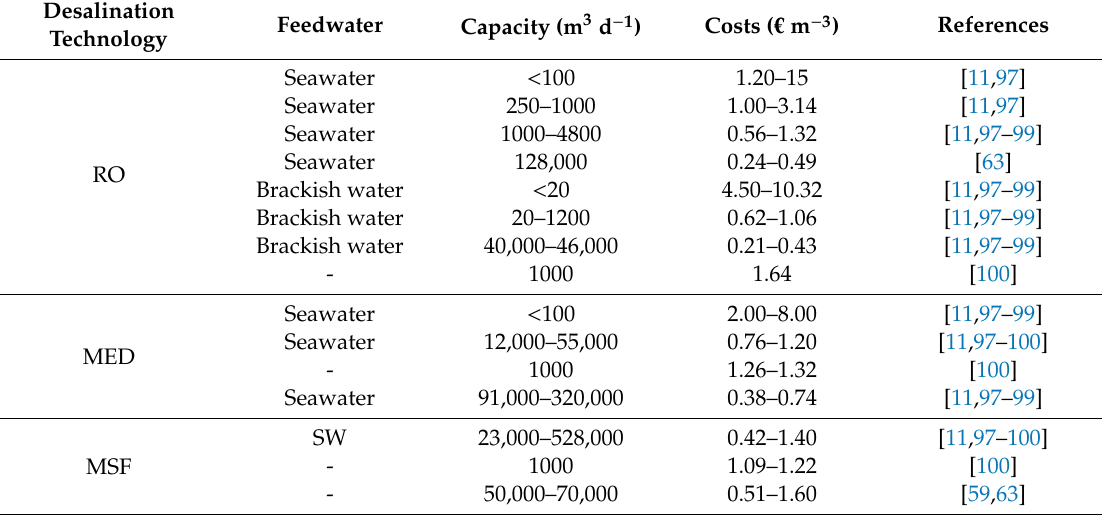
Table 6. Costs of water for di ff erent desalination technologies according to treatment capacity and